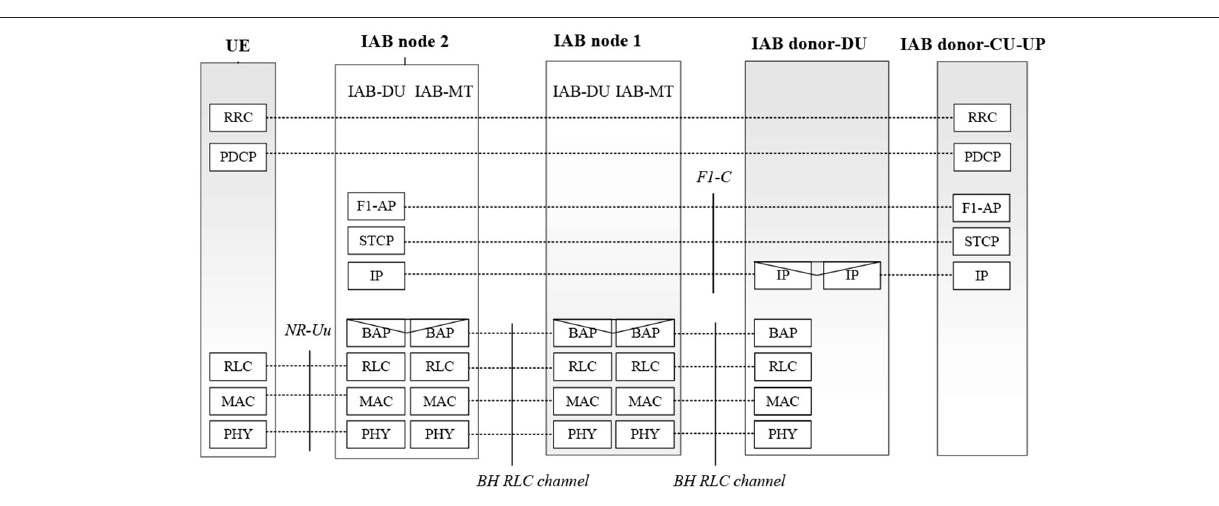
FIGURE 4 | Integrated access and backhaul control plane protocol stack according to 3GPP